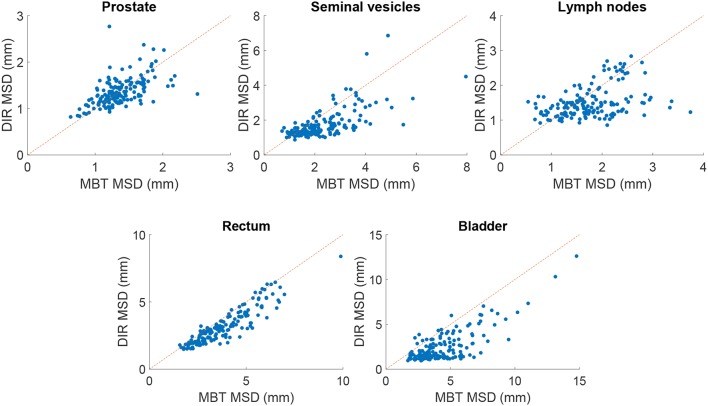
Scatter plot of the MSD in mm of elastix DIR with 100 iterations compared with the results of MBT. The red line indicates the line of no change, i.e., points below this line indicate improvement of DIR over MBT.